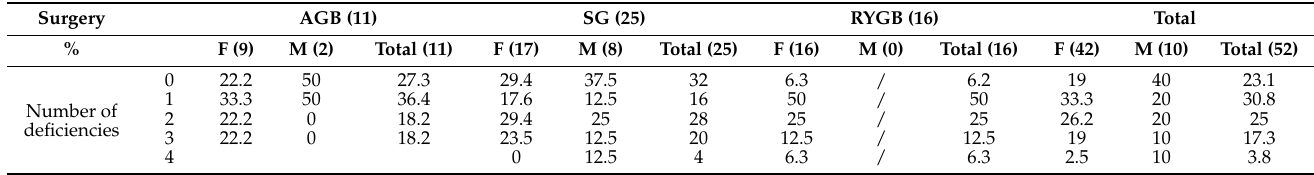
Table 4. Number of nutritional deficiencies in patients by